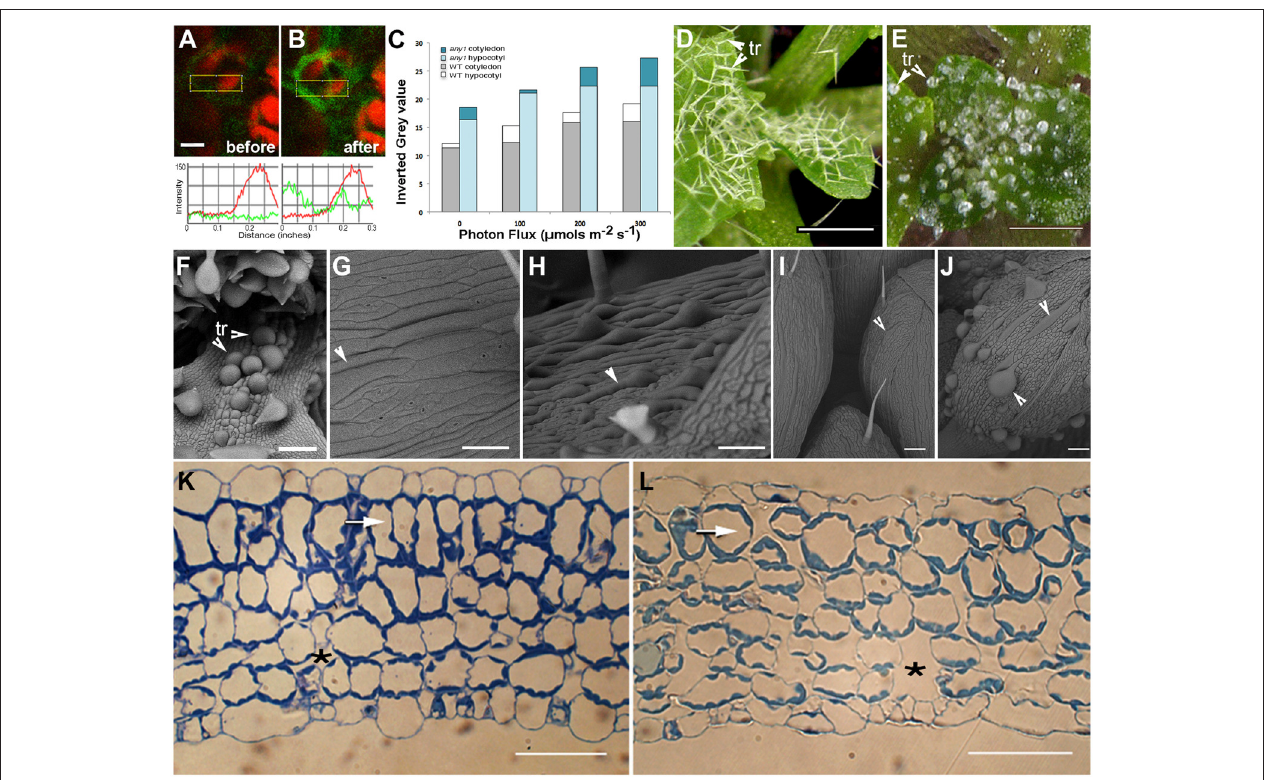
FIGURE 2 | Observations suggesting changes in subcellular H 2 O 2 levels in response to HL and characteristic features of the any1 mutant in comparison with wild type Arabidopsis. (A,B) A leaf epidermal cell in a transgenic Arabidopsis plant expressing HyPer-cytosolic probe (A) before and (B) after exposure to HL. Line traces based on the boxed areas are provided below the fluorescent images and show a nearly 2.5-fold general increase in green fluorescence intensity suggesting an increase in cellular H 2 O 2 levels. Red chlorophyll auto-fluorescence is from chloroplasts in the mesophyll layer. (C) DAB staining of WT and any1 mutant leaves exposed to increasing light intensity suggesting relatively higher H 2 O 2 production and catalase activity in any1 cells. (D,E) Leaf epidermal trichomes (tr) in WT (D) and the any1 mutant (E) exhibit spectacular differences in growth anisotropy. (F) A scanning electron (SEM) image shows that the glassy-appearing trichomes as well as some non-trichome cells near the leaf base appear swollen due to isotropic growth in any1 . (G,H) Arrowheads pointing to elongated cells in WT leaves suggest their relatively flat nature (G) as compared to the bulged cells in petioles of any1 (H) mutant. (I,J) Giant cells in the sepal epidermis in WT ( I ; arrowhead) are relatively thin and unobtrusive compared to the large, swollen cells in the mutant ( J ; arrowheads). (K,L) Toluidine blue-O stained sections of WT (K) and any1 (L) leaves at a similar stage of development show differences in the relative size of cells and intercellular spaces ( * ). The sub-epidermal layer in the mutant (arrows) is relatively disorganized and cells show approximately 35% decrease in elongation (19.3 µ m vs. 29.7 µ m long in wild type). Size bars in (A) = 5; (D,E) = 250 ; (F–J) = 100; (K,L) = 50 µ